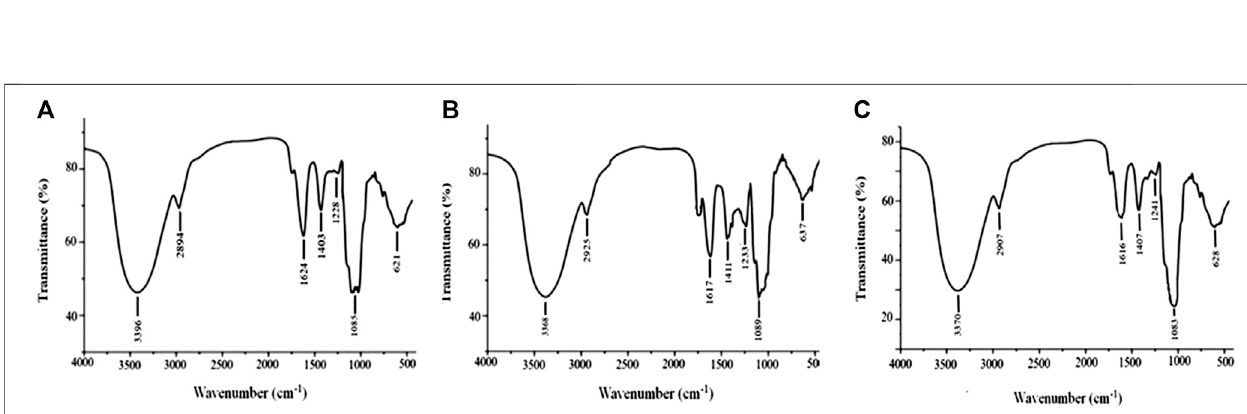
FIGURE 2 | HPLC chromatograms of the monosaccharide control substance mixture (A) and monosaccharide composition of APS (B) , APS-I (C) , APS-II (D) and APS-III (E) . 1 - mannose, 2-rhamnose, 3-galacturonic acid, 4-N-acetylglucosamine, 5-glucose, 6-galactose, 7-arabinose, 8-fucose.